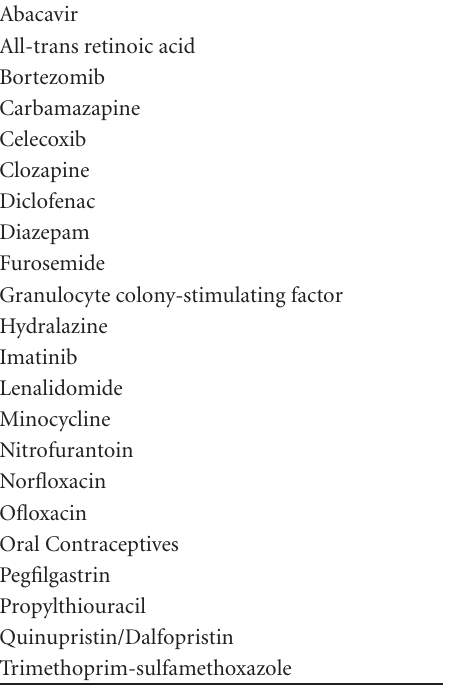
Table 1: Drugs associated with Sweet’s Syndrome.